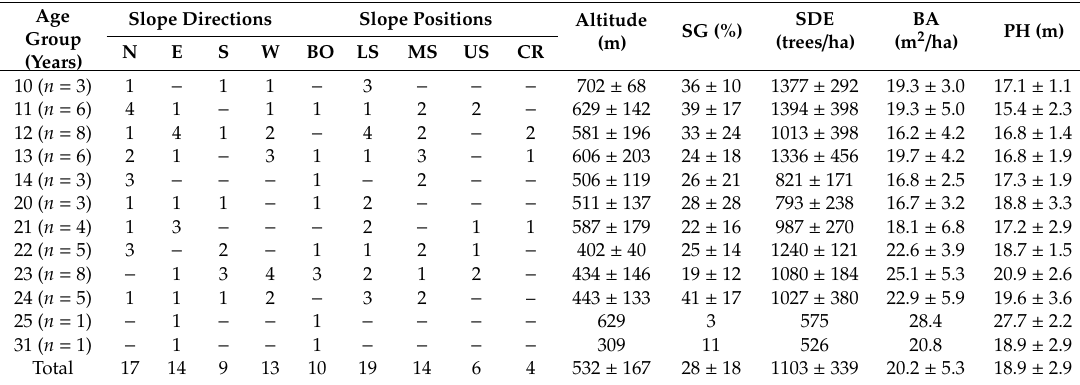
Table 1. Characteristics of sample plots and trees. North (N); east (E); south (S); west (W). Bottom (BO); lower slope (LS); middle slope (MS); upper slope (US); crest (CR). Slope gradient (SG). Basal area (BA). Stand density (SDE). Predominant height (PH).